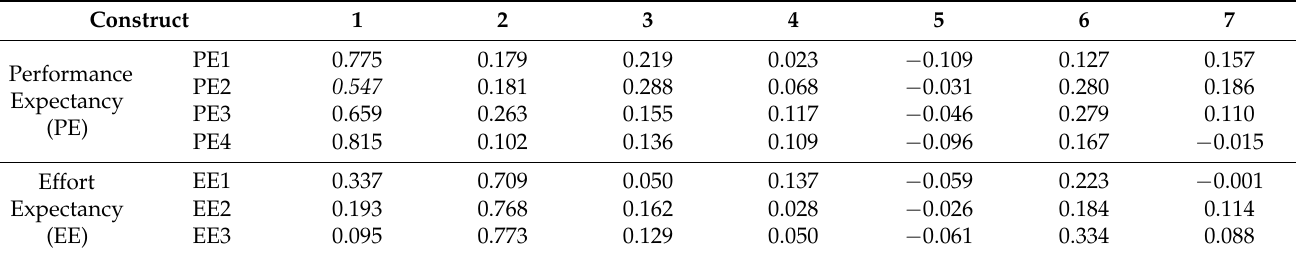
Table A2. Rotated component matrix from